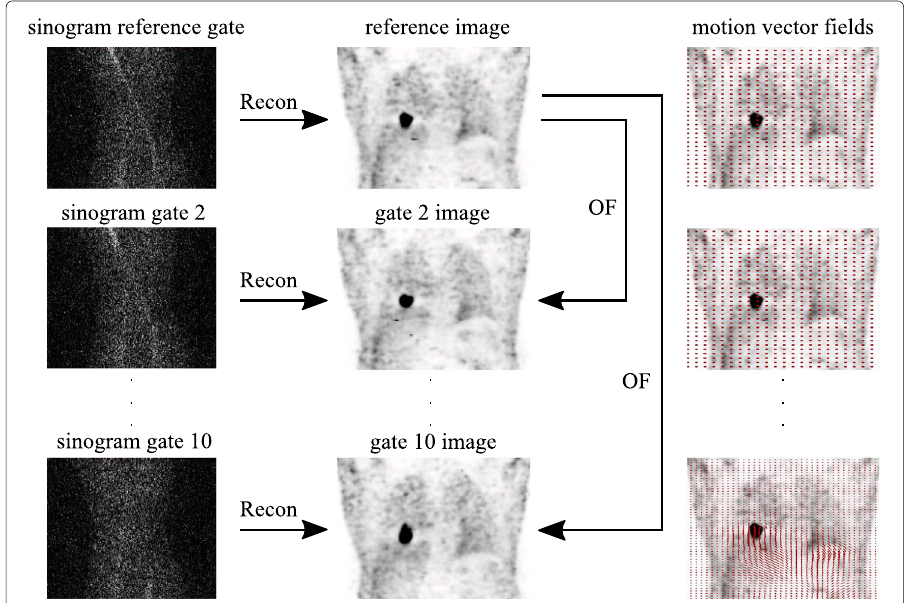
Fig. 2 Gate-to-gate motion correction